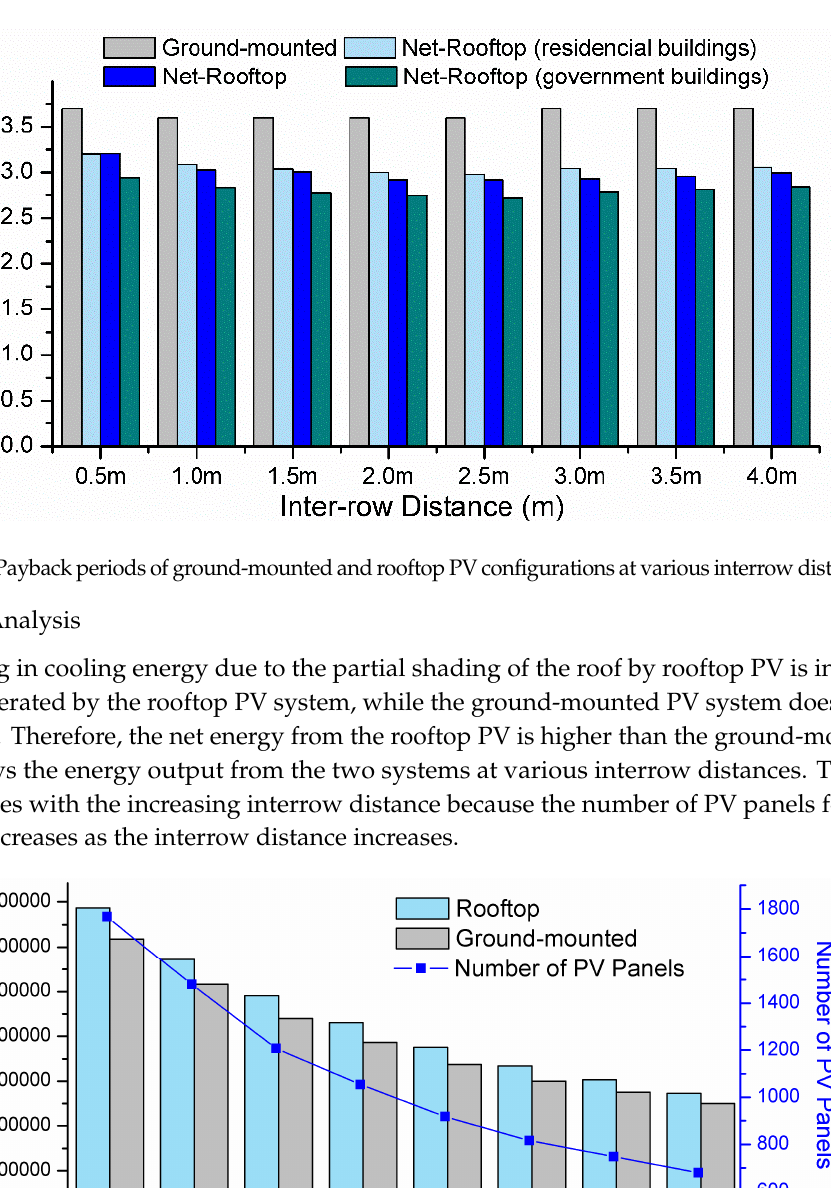
Figure 11. Energy output at various interrow distances.